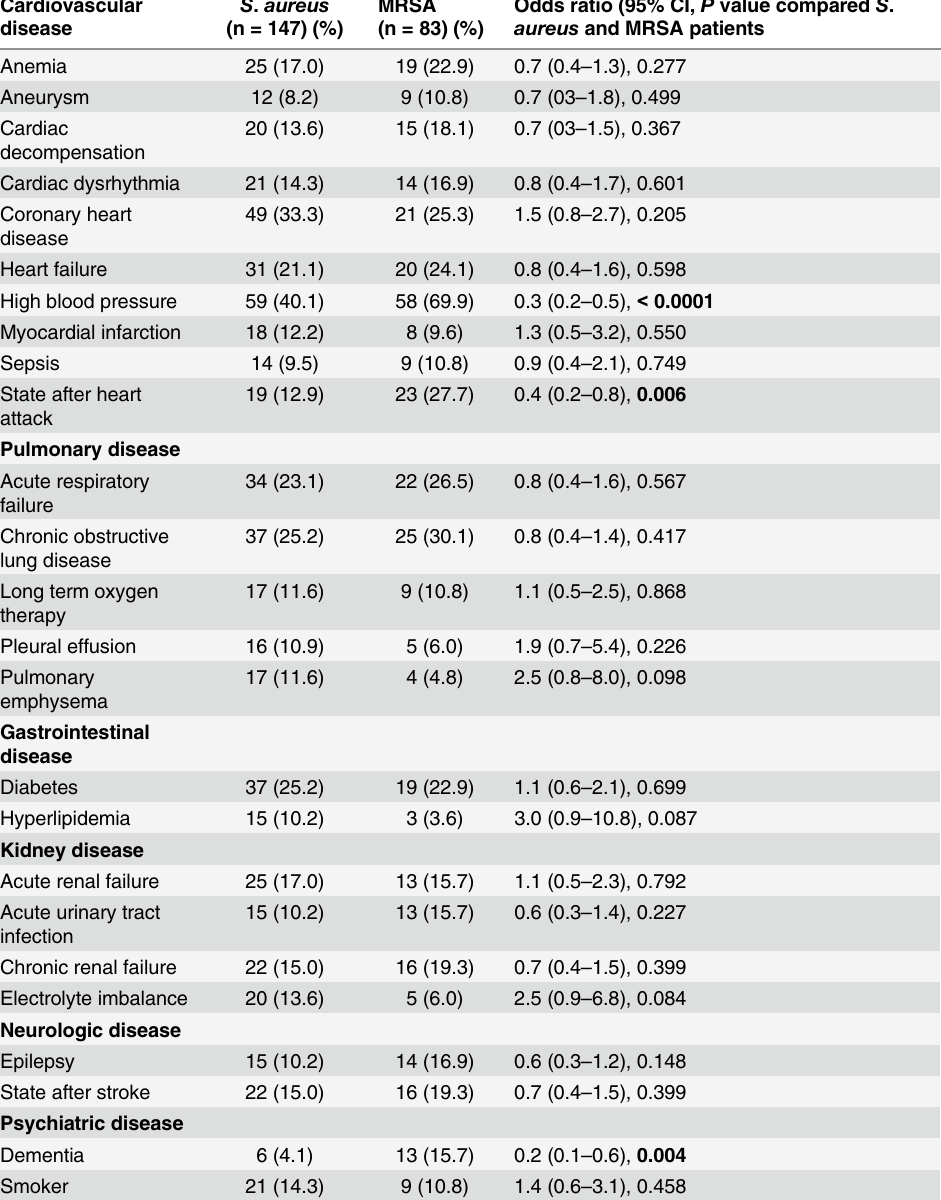
Table 5. Acute and chronic comorbidities of patients with pneumonia caused by S . aureus compared to MRSA. Comorbidities were only considered if they were more than 10% in one of the groups even if they were less than 10% in the other